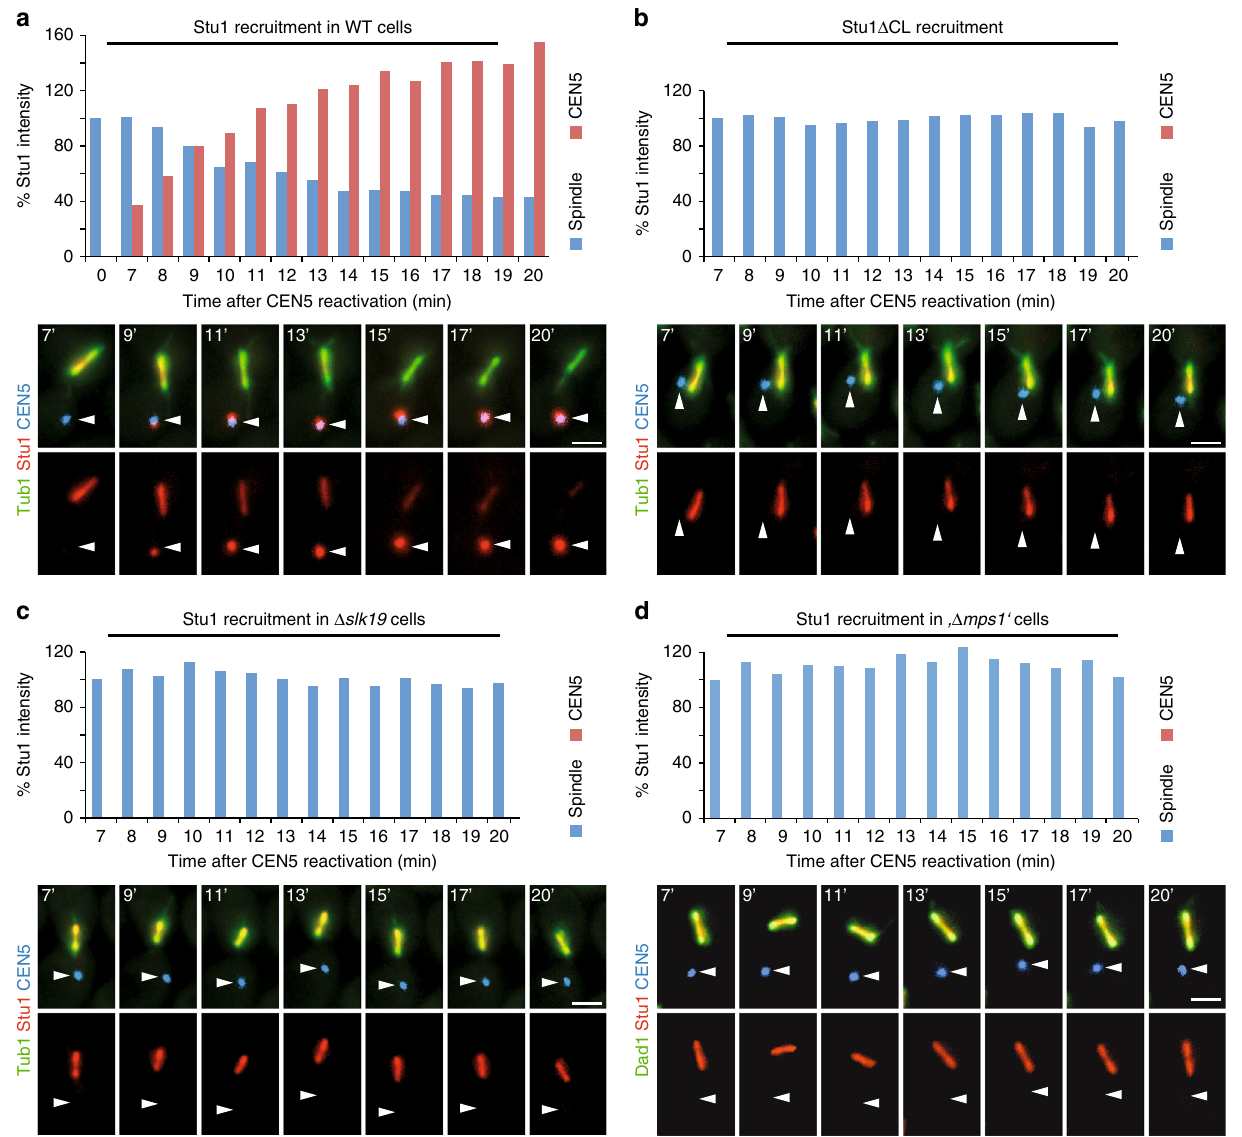
Fig. 2 Sequestering at uaKTs withdraws Stu1 from spindle MTs and attached KTs. a – d Genotypes of the used strains are listed in Supplementary Table 1. Cells with the indicated genotypes were arrested in metaphase. Then the centromere DNA of chromosome V was inactivated and subsequently reactivated, thus producing an uaKT of chromosome V (white arrowheads). The upper panel of micrographs represents the overlay of the three signals, the lower panel the Stu1 signal. The average amount of Stu1 that localized to uaKTs or the spindle region (spindle) at the indicated timepoints after KT reactivation is shown for one of two independent experiments. Number of analyzed cells are shown in Supplementary Table 3. The amount of Stu1 measured for the spindle region 7 min after KT reactivation was set to 100%. Bars, 2 µ m. a Stu1 is sequestered at uaKTs and is removed from the spindle and attached KTs. b Stu1 Δ CL fails to get sequestered at uaKTs and remains at the spindle and attached KTs. WT Stu1 in the background was depleted. c In the absence of Slk19, Stu1 sequestering fails and Stu1 remains at the spindle and attached KTs. d In the absence of Mps1, Stu1 sequestering fails and Stu1 remains at the spindle and attached KTs. Mps1 was depleted during the metaphase arrest (, Δ mps1 ’